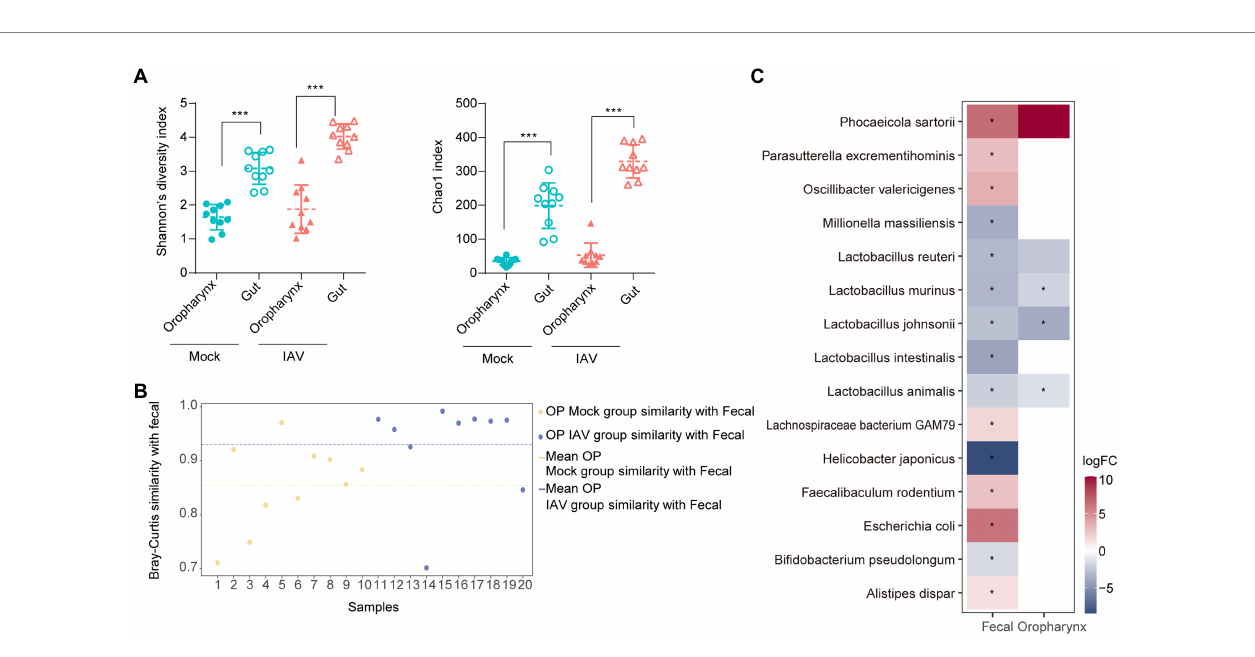
FIGURE 6 Comparison of oropharyngeal and gut microbiota during IAV infection (A) Comparison of the Shannon diversity and Chao1 indices between gut and oropharyngeal microbiota in IAV and mock groups. (B) Similarity analysis between gut and oropharyngeal microbiota in IAV and mock groups. (C) Distribution of gut and oropharyngeal differential species between mock and IAV groups screened by Lefse analysis. Statistical analyses of Shannon index, Chao1 index and bacterial taxa abundance were conducted by using the Mann–Whitney test. * p < 0.05, ** p < 0.01, *** p < 0.001.